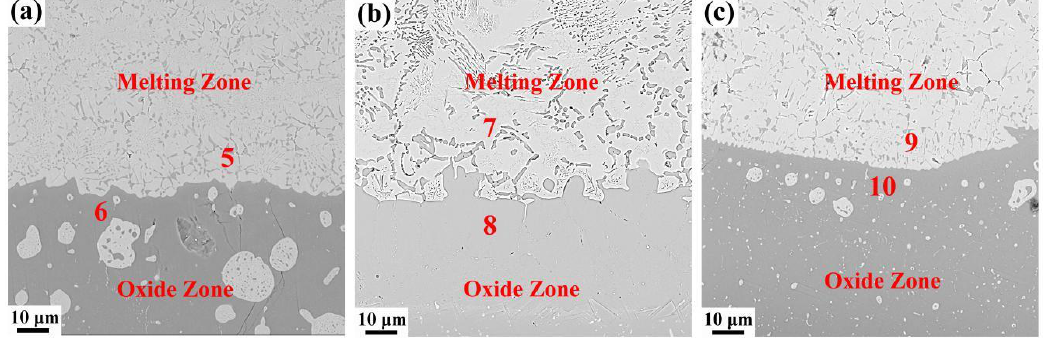
Figure 7. The interface between melting zone and oxide zone, ( a ) Ti-25V-10Cr, ( b ) Ti-25V-15Cr, ( c ) Ti-25V-20Cr.